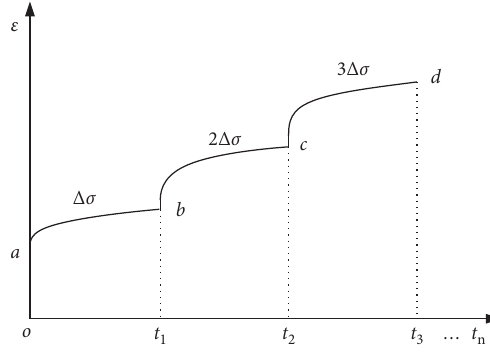
Figure 11: Typical creep curve for step loading.